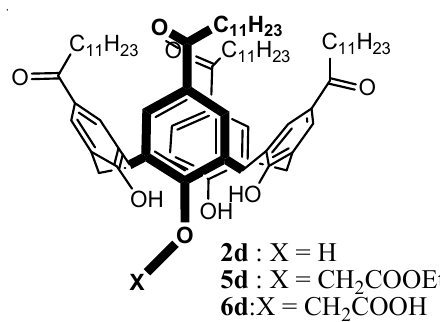
Figure 4. Formulae of 2d , 5d and 6d .